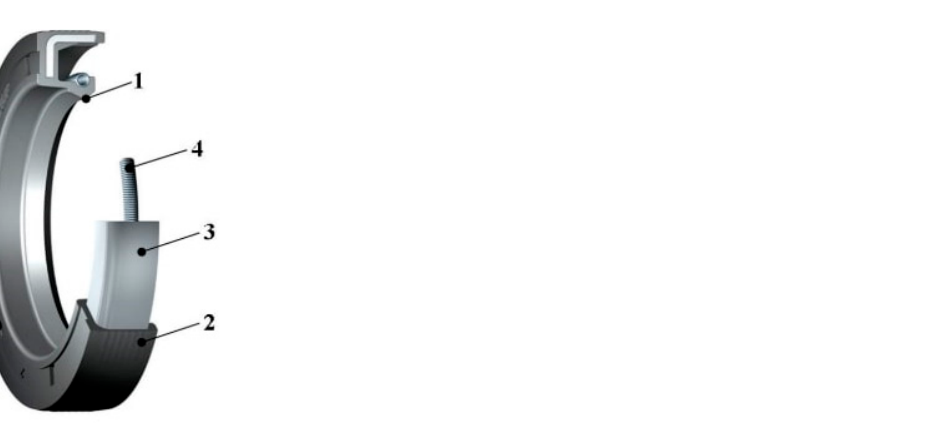
Figure 1. Radial Lip Seal Schematic [1] without dust lip to identify main components of this particular type of seal. 1. Sealing lip, 2. Outer static seal, 3. Supporting metal reinforcement, 4. garter spring.